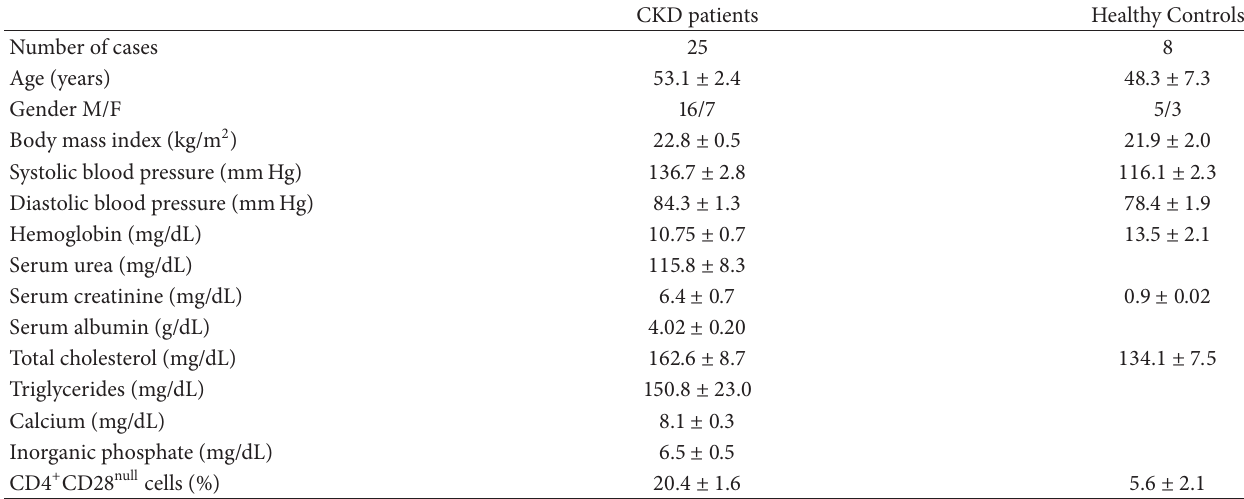
Table 1: Demographic and biochemical characteristics of the